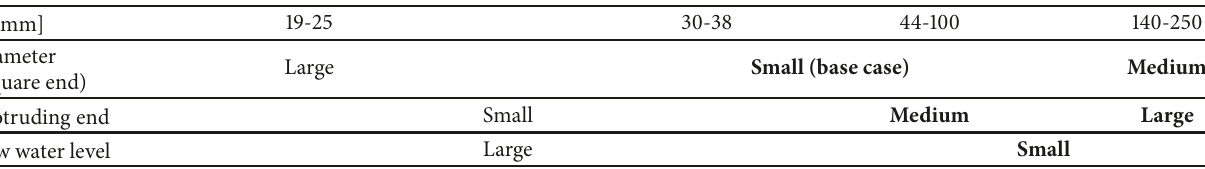
Table 3: Effects of parameters on CCFL at square top end comparing with conditions of the square top end and water level at midlevel for D = 30-100 mm (“Medium” is uncertainty range of about 5-10 % for 𝐶 K , for “Large” different correlation is recommended, bold area; database used for (9)).